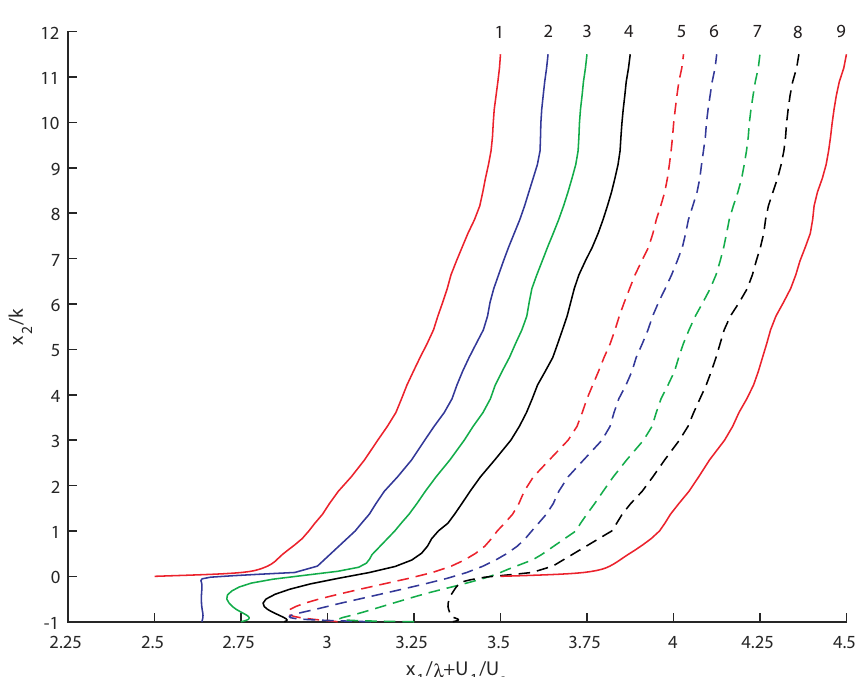
Figure 14. Vertical profiles (1, 2, ..., 9) of predicted mean-velocities U 1 for Run 2 at 9 locations within a pitch ( λ ) from the 3rd bar (middle) to the 4th bar (middle). The longitudinal coordinates are x 1 / λ equal to 2.500, 2.638, 2.750, 2.875, 3.029, 3.125, 3.250, 3.363, and 3.500, respectively. The average of the velocities at the water surface is taken as the freestream velocity. The locations are in the channel center plane.